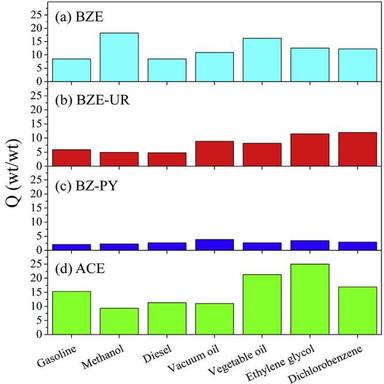
Absorption capacity (Q ¼ Qf/Q0) of the N-CFS (BZE, BZE-UR, BZ-PY, and ACE). Results for gasoline, methanol, diesel, vacuum oil, vegetable oil, ethylene glycol, and dichlorobenzene. The material absorbed was removed by burning the N-CFS, recuperating its initial weight (Q0). N-CFS, nitrogen-doped carbon fiber sponge; BZ-PY, pyridine-benzylamine; ACE, acetonitrile-ethanol; BZE-UR, BZE saturated with urea; BZE, benzylamine-ethanol.